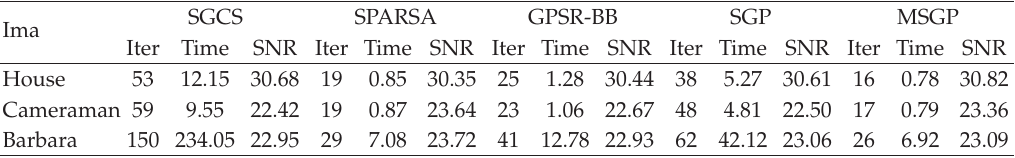
Table 1: Test results for SGCS, SPARSA, GPSR-BB, SGP, and MSGP in image